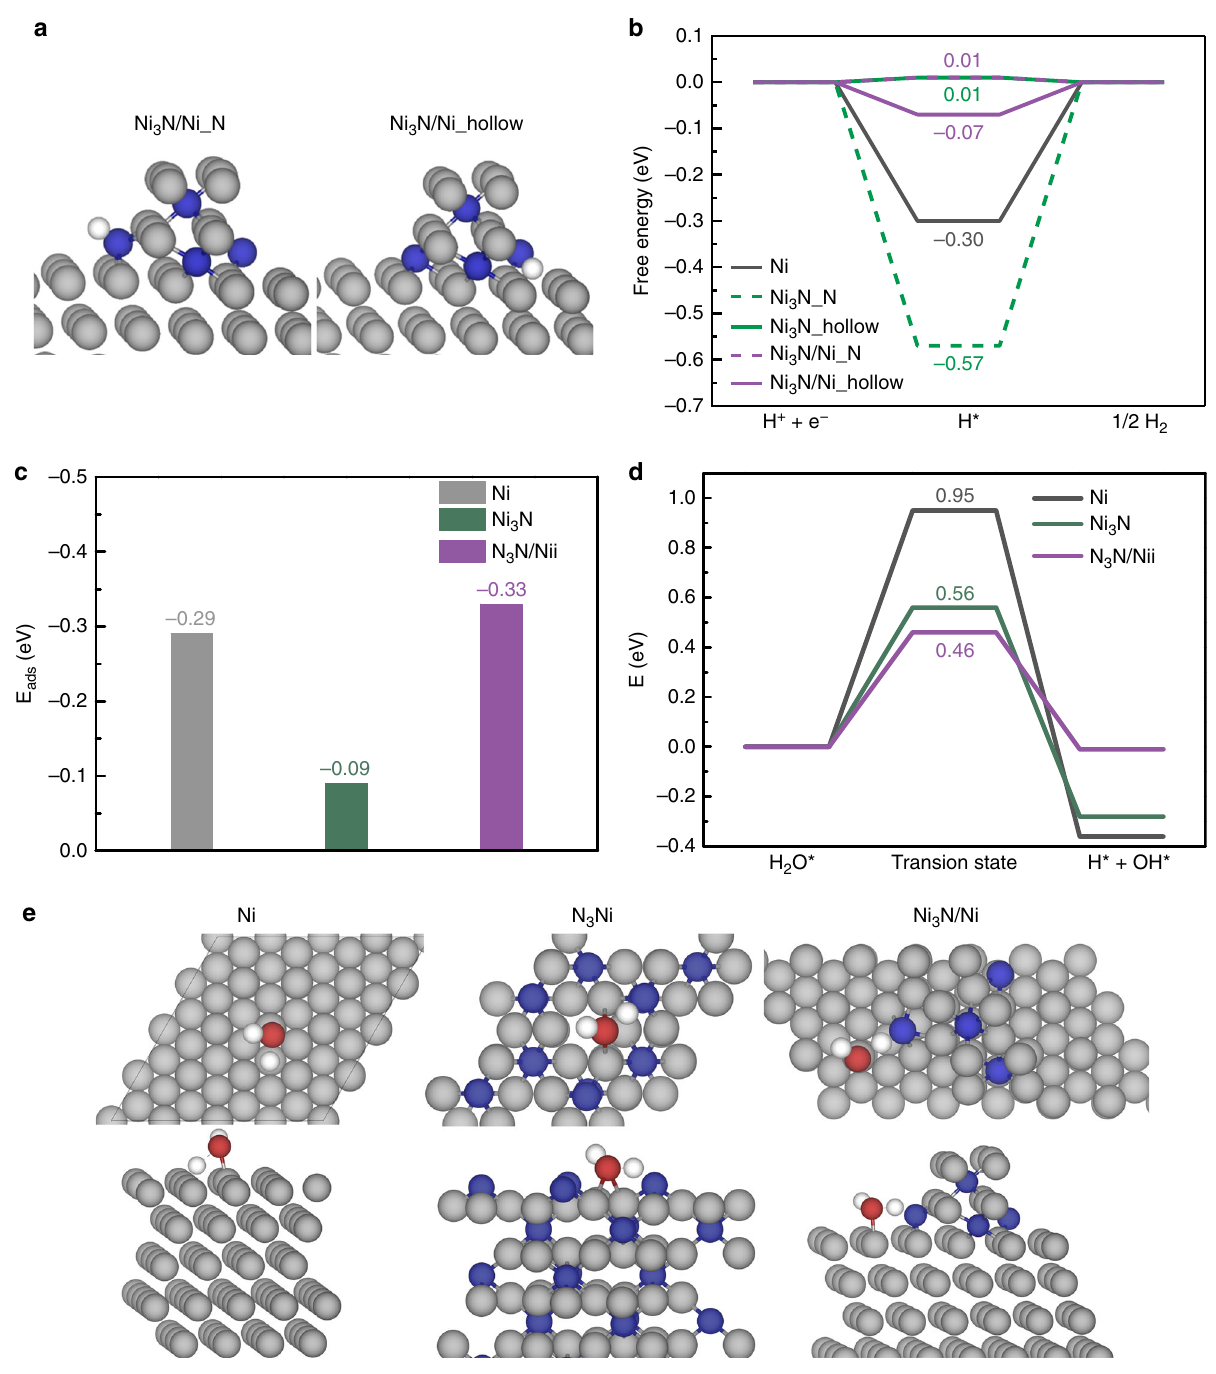
Fig. 3 DFT calculation results. a DFT-optimized structures of hydrogen adsorption at two interfacial sites of Ni 3 N/Ni. b Hydrogen adsorption free energy ( Δ G H* ) on Ni, Ni 3 N, and Ni 3 N/Ni. c Adsorption energy of water on Ni, Ni 3 N, and Ni 3 N/Ni. d Energy barrier for water dissociation on Ni, Ni 3 N, and Ni 3 N/Ni. e Transition state structures for water dissociation over Ni, Ni 3 N, and Ni 3 N/Ni, showing both the top view (top of e ) and side view (bottom of e ) of each structure. Color code: Ni: gray; N: blue; O: red; H: merely 0.34 mA cm − 2 . The exchange current density was esti- Ni and Ni/NF, respectively. It was found that Ni 3 N/Ni/NF mated from the micro-polarization region within a small poten- showed higher speci fi c activity than Pt/NF for HOR under similar tial window from − 20 to 20 mV vs. RHE (Supplementary experimental conditions, even if the current densities were nor- Fig. 47). Both Ni 3 N/Ni/NF and Pt/NF showed electrocatalytic malized by their respective BET surface areas and/or ECSAs HER and HOR activities starting at nearly zero overpotential in (Supplementary Figs. 48 – 49). The stability of Ni 3 N/Ni/NF for 0.1 M KOH. The calculated exchange current density of Ni 3 N/Ni/ long-term H 2 oxidation was assessed via chronoamperometry at NF was 3.08 mA cm − 2 , which was 1.4 and 17.6 times that of Pt/ 0.09 V vs. RHE in H 2 -saturated 0.1 M KOH and compared with